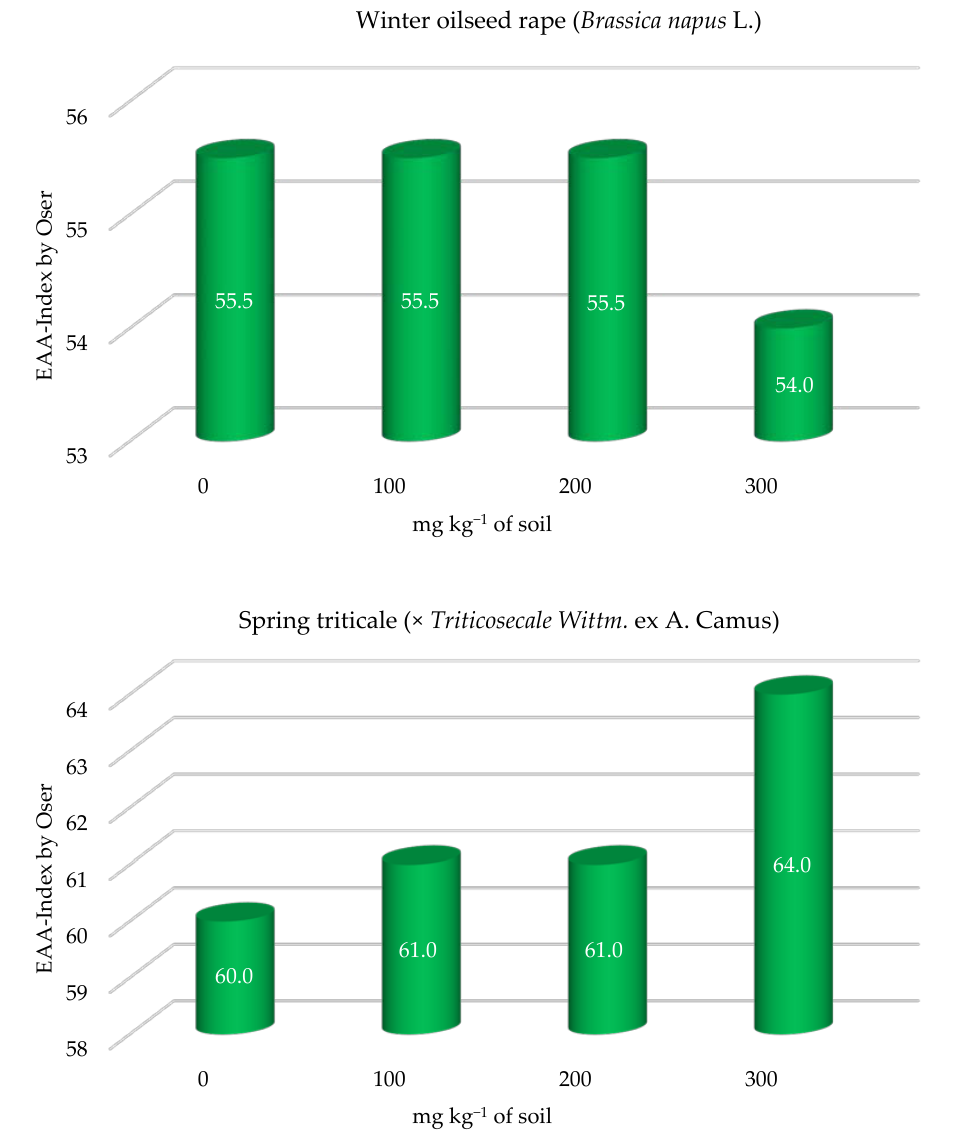
Figure 2. Nutritive value of protein in the above-ground parts of winter oilseed rape ( Brassica napus L.) and grain of spring triticale ( × Triticosecale Wittm . ex A. Camus) depending on soil contamination with fluorine.